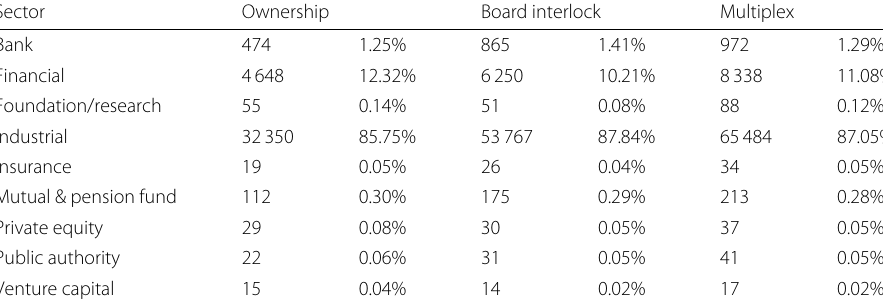
Table 1 Division of firms over economic